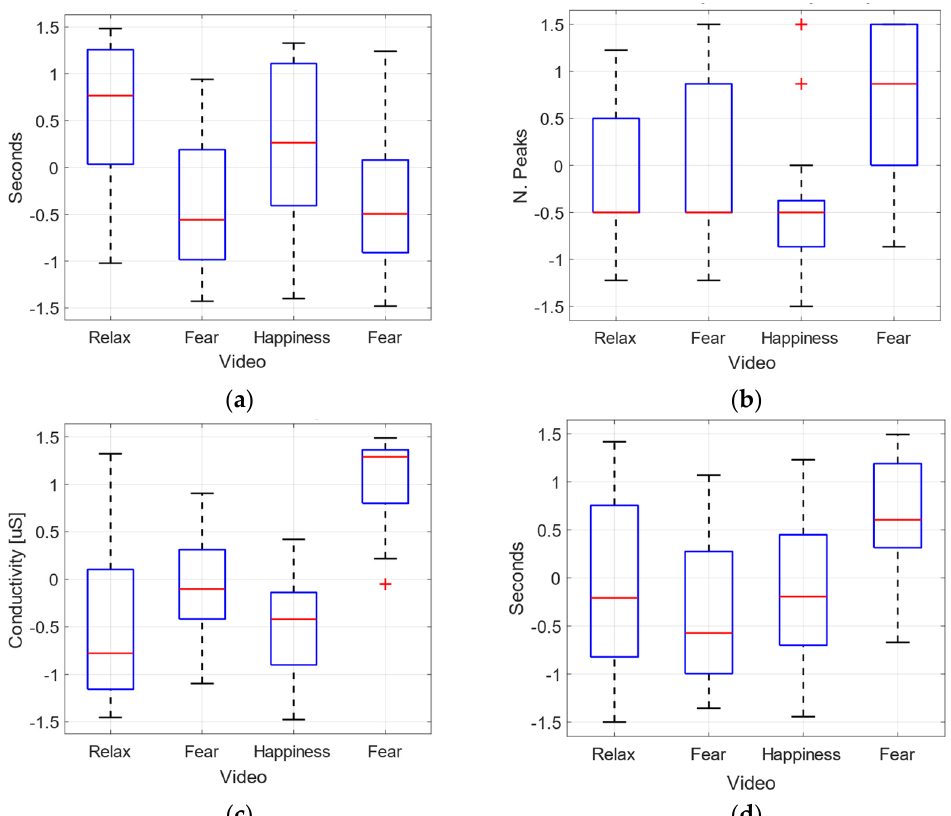
Figure 10. Normalized physiological features per video. ( a ) IBI. ( b ) number of phasic GSR peaks. ( c ) mean of GSR. ( d ) HRV rmssd.